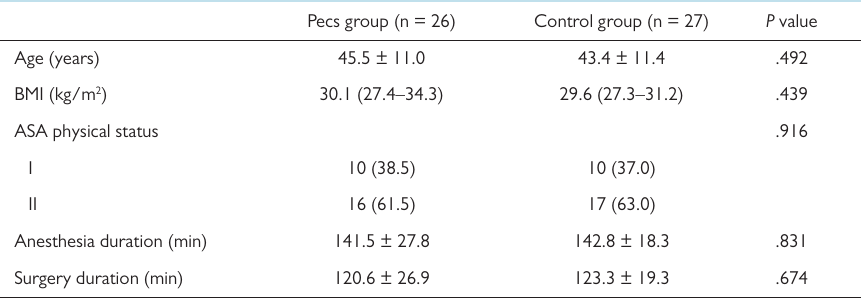
Figure 1. Flow chart of Table 1. Demographic Characteristics of Patients